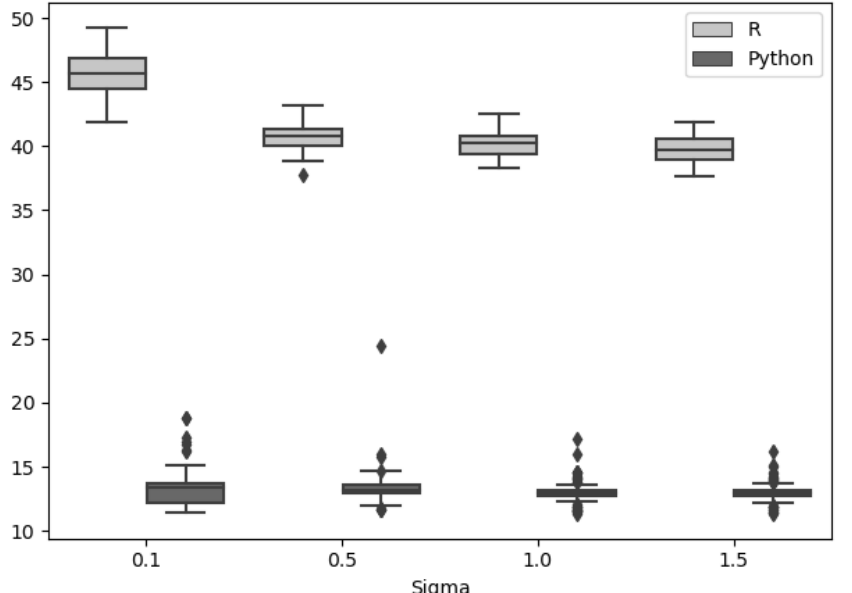
Figure 5. Execution times in seconds (in the y axis), using R (in light gray) and Python (dark gray), for standard deviations σ in { 0.1,0.5,1.0,1.5 } for the 100 simulated